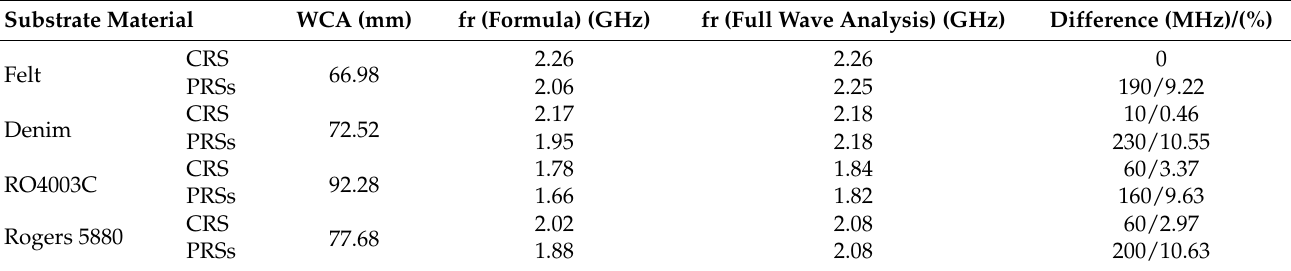
Table 7. Overall Results of CRS and PRSs